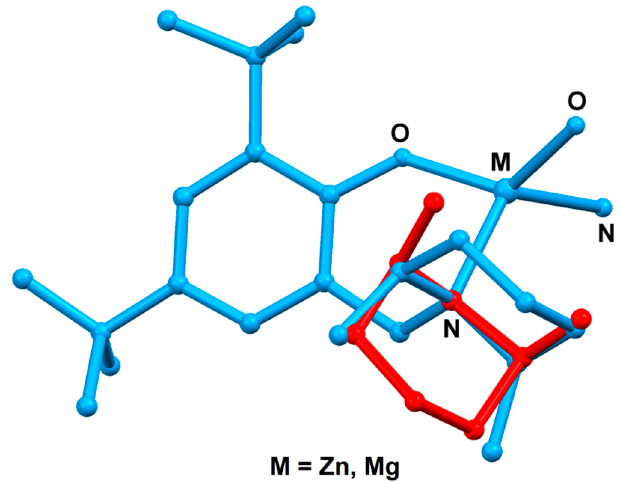
Figure 3. Disordered dimethylpiperidinyl groups observed in molecular structures of zinc and magnesium complexes.